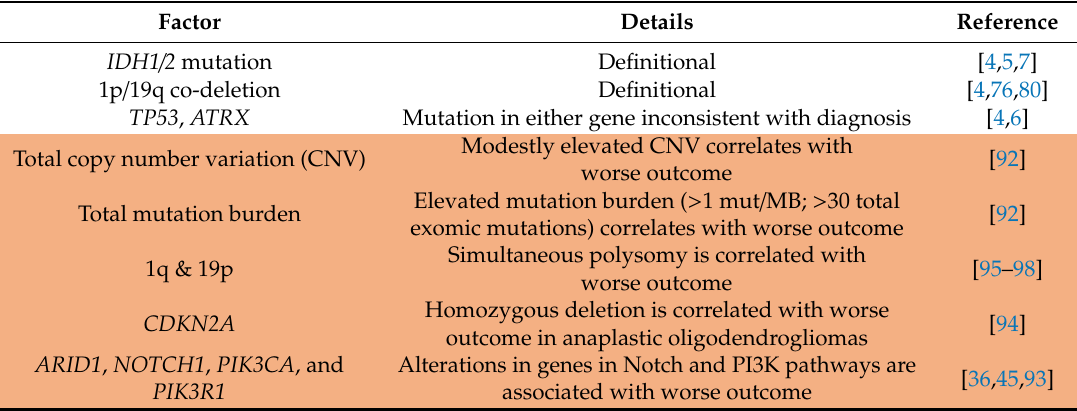
Table 2. Prognostic factors in IDH-mutant, 1p / 19q co-deleted